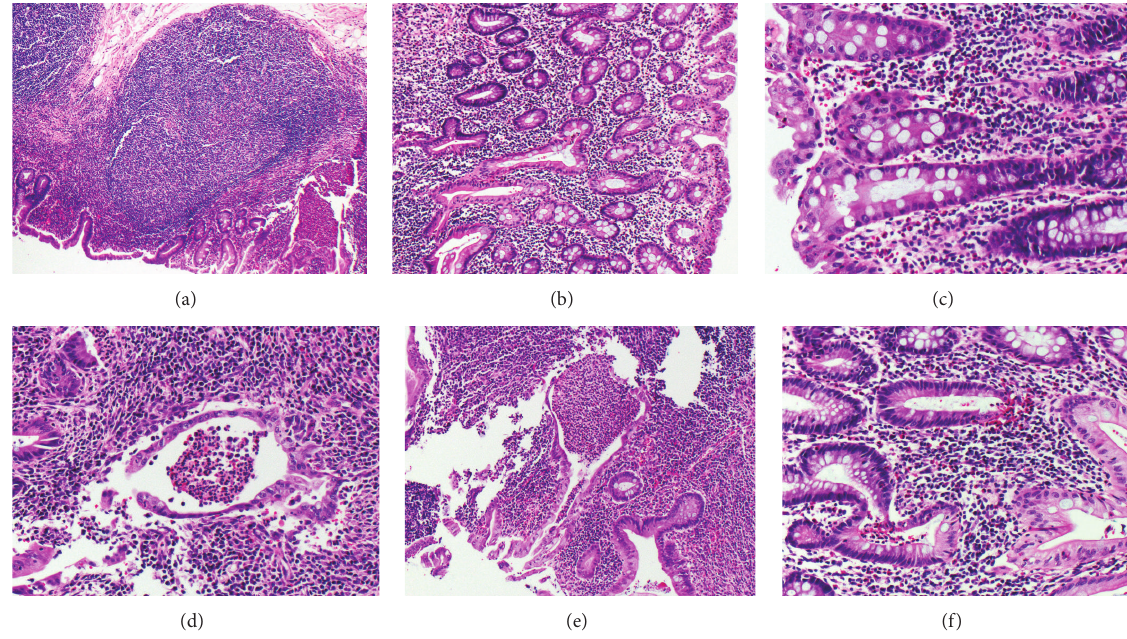
Figure3:H&Estainedsectionsdemonstratingfocalchronic-activecolitis,consistentwithCrohn’sdisease.(a)Lowpowerviewshowingdense inflammatory infiltrate composed of lymphoid hyperplasia (center and upper left) combined with transmural neutrophilic inflammation forming deep fissuring ulcer (bottom right) (40x), (b-c) crypt distortion, reactive epithelial atypia with neutrophilic inflammation ((b) 100x, (c) 200x), and (d–f) marked crypt distortion with extensive crypt abscesses in the epithelium ((d) 200x, (e) 100x, and (f)